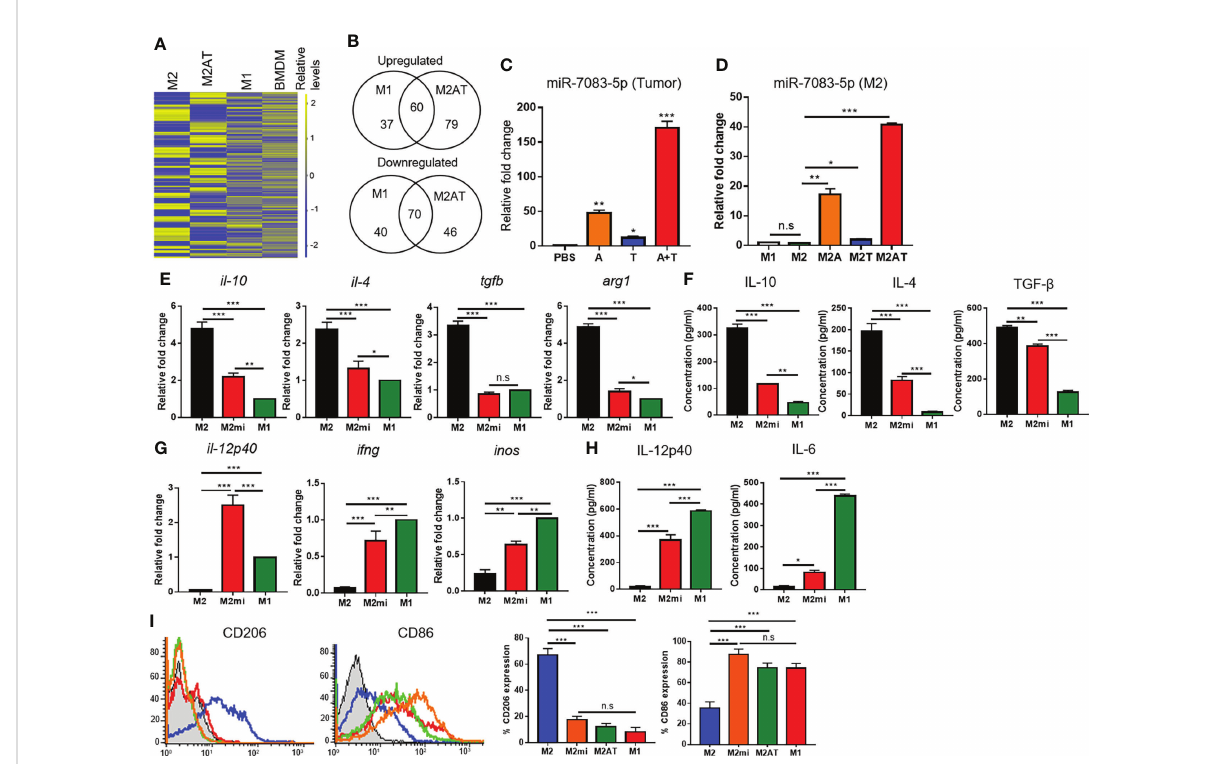
FIGURE 5 miR-7083-5p is involved in the reprogramming of M2-type macrophage into an M1-like phenotype upon treatment with the combination of 5- aza-dC and TSA. (A) Hierarchical clustering heat map showing the relative levels of miRNAs in M2-type macrophages (M2) after treatment with the combination of 5-aza-dC and TSA (M2AT). M1 macrophages (M1) and bone marrow-derived monocytes (BMDMs) were used as controls. (B) Venn diagrams showing the number of upregulated and downregulated miRNAs in M2AT and M1, as compared to those in M2. (C, D) qRT-PCR analysis of the relative levels of miR-7083-5p in 4T1 tumor tissues, after treatments with 5-aza-dC (referred as A) and TSA (referred as T), alone or in combination (A+T), (C) and in M2 macrophages, after treatments with 5-aza-dC (M2A) and TSA (M2T), alone or in combination (D) . (E, G) qRT-PCR analysis of the relative mRNA levels of M2- (E) and M1-type (G) cytokines and markers in M2 macrophages after transfection of miR- 7083-5p (M2mi). (F, H) ELISA of the concentrations of M2- (F) and M1-type (H) cytokines secreted into the culture medium of M2 macrophages after transfection of miR-7083-5p. (I) Flow cytometric analysis of CD206 and CD86 expression levels in M2mi and M2AT. *, P <0.05; **, P <0.01; ***, P <0.001; n.s., not signi fi cant ( n =3 per group), as assessed using one-way ANOVA. Data represent the mean ± SD of three separate experiments performed in triplicates. *, P <0.05; **, P <0.01; ***, P <0.001; n.s., not signi fi cant, as assessed using one-way ANOVA followed by Tukey ’ s multiple comparison post-hoc